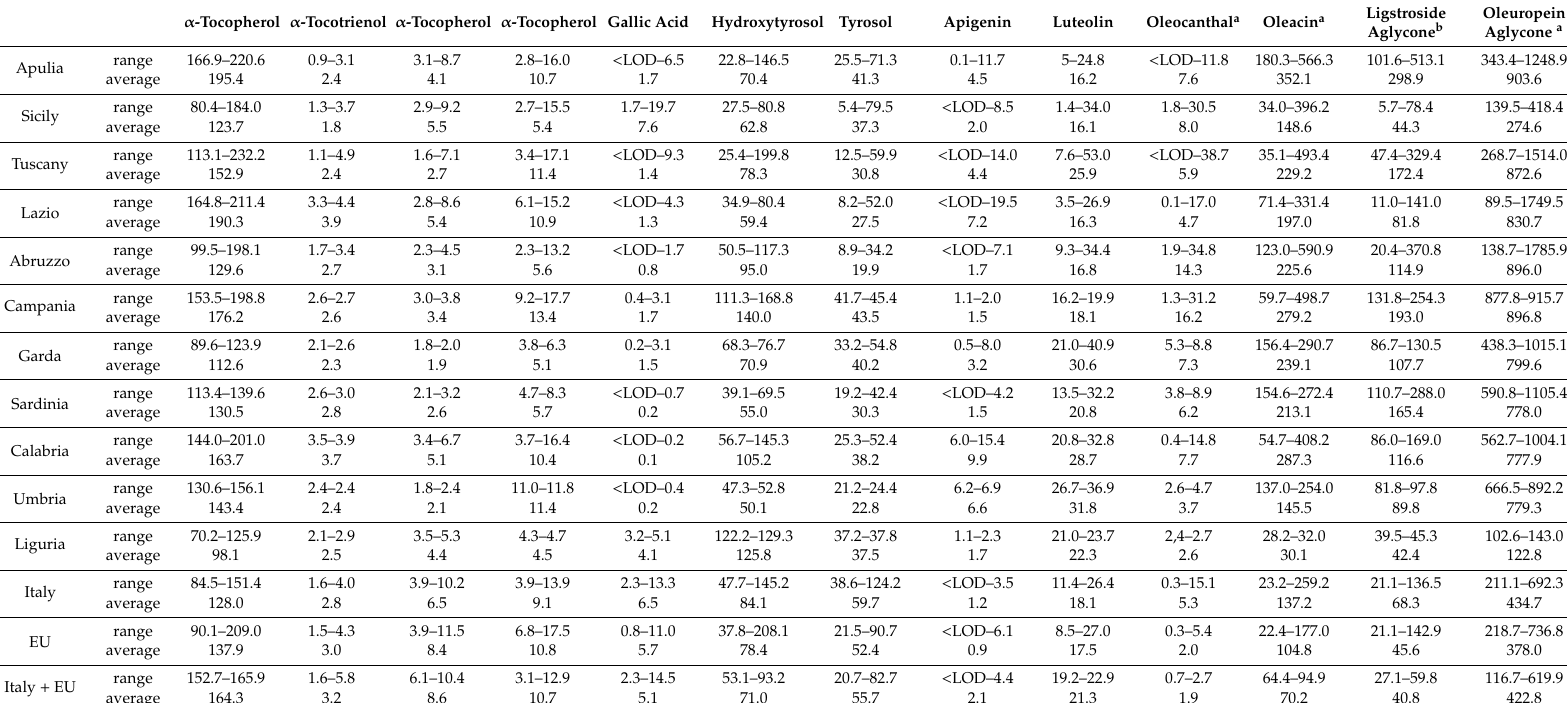
Table 2. Content (mg kg − 1 ) of bioactive molecules in olive oil samples analyzed divided into selected country / region. α -Tocopherol α -Tocotrienol α -Tocopherol α -Tocopherol Gallic Acid Hydroxytyrosol